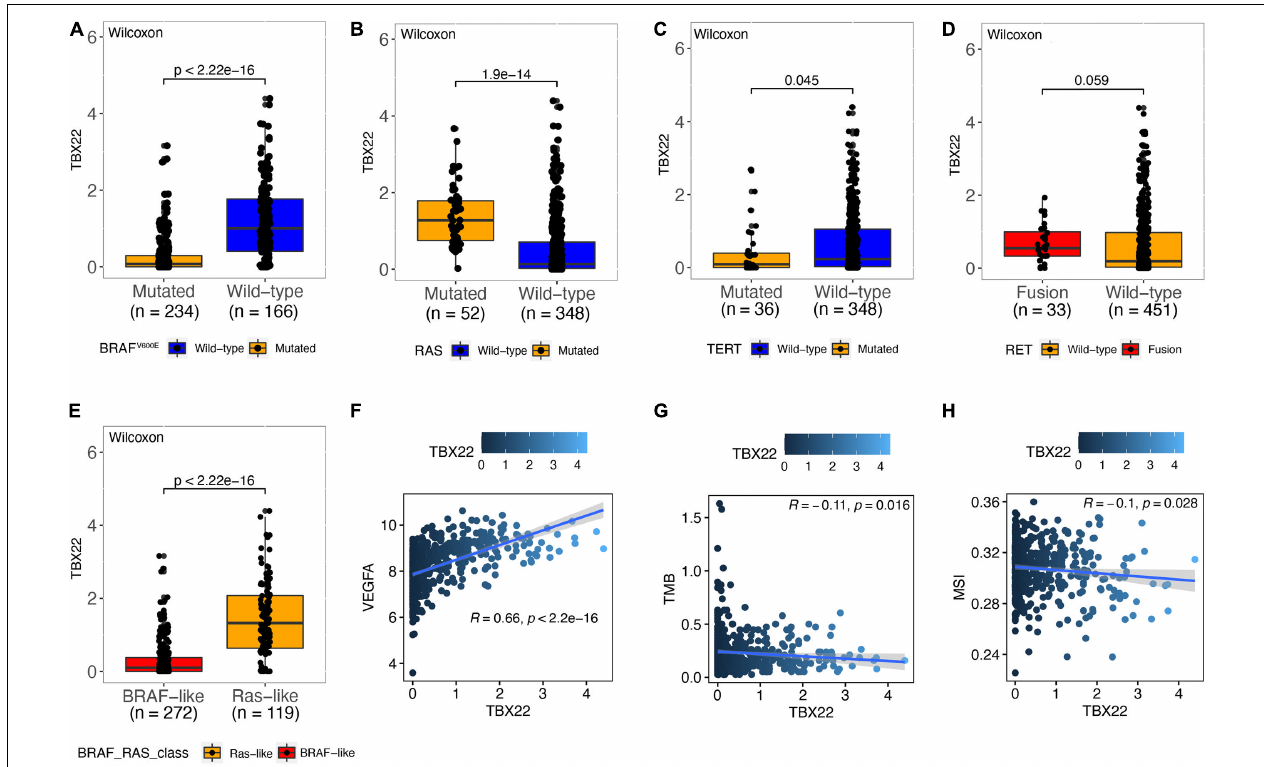
FIGURE 3 | The relationship between TBX22 expression and molecular features of PTC. (A–E) Distribution of the TBX22 expression in PTC patients stratified by (A) BRAF V 600 E status, (B) RAS status, (C) TERT status, (D) RET status, and (E) BRAF-RAS-class. (F–H) Spearman correlations between TBX22 and (F) VEGFA expression, (G) TMB, and (H) MSI score in PTC